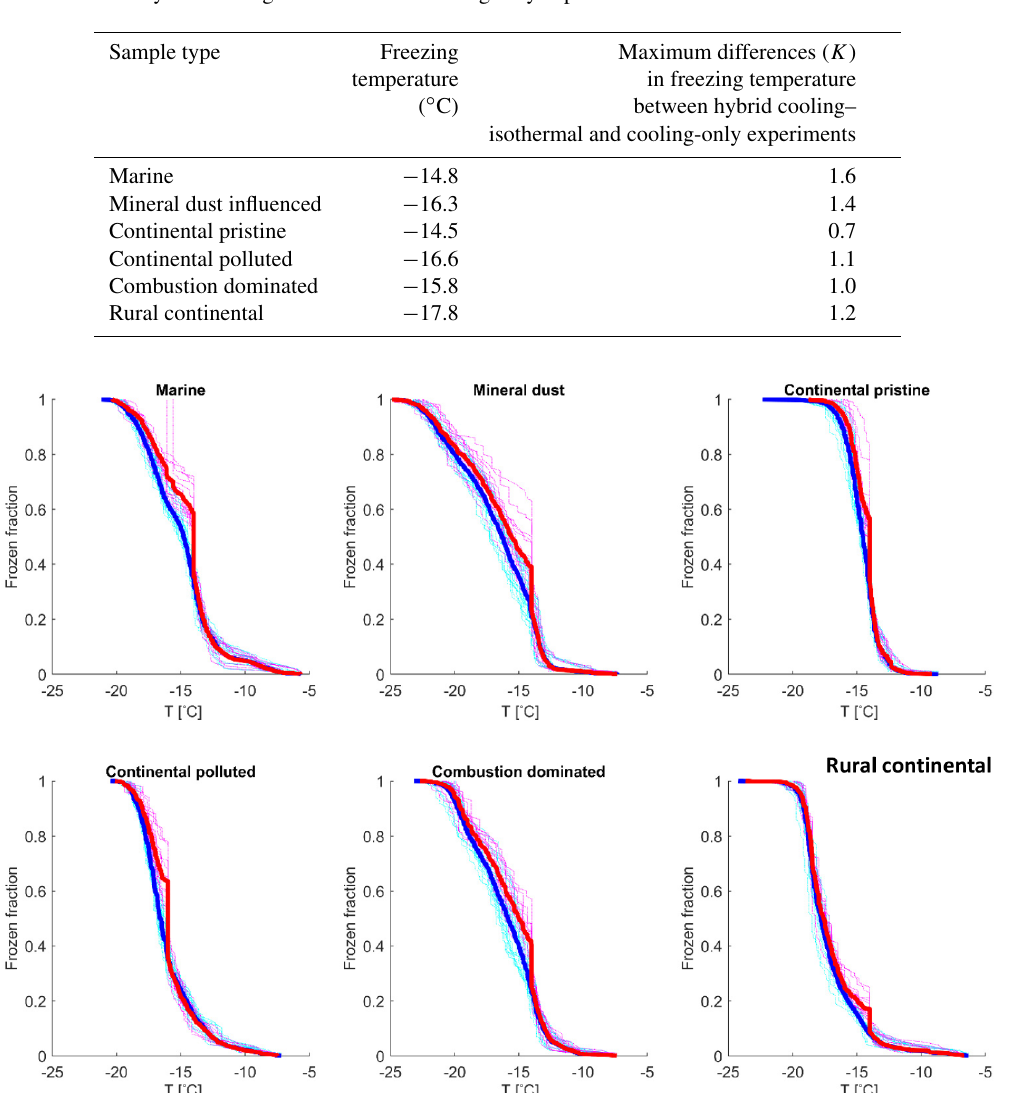
Table 5. Temperatures with frozen fractions of 50% during constant cooling-only experiments. Also shown are maximum differences in freezing temperature between hybrid cooling–isothermal and cooling-only experiments after 2h.